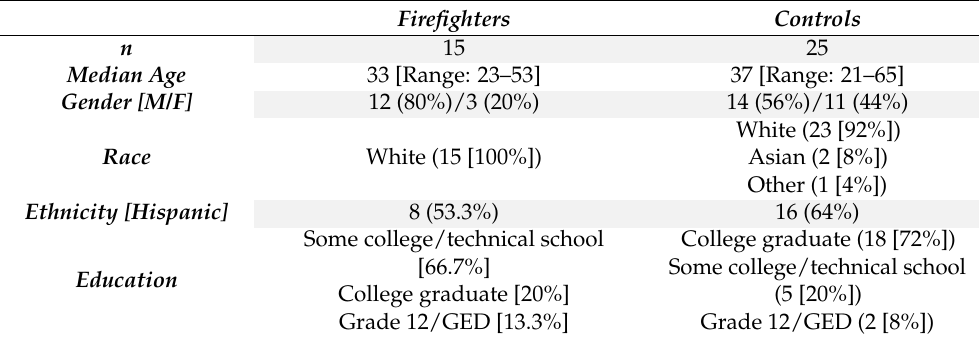
Table 1. Firefighter and control